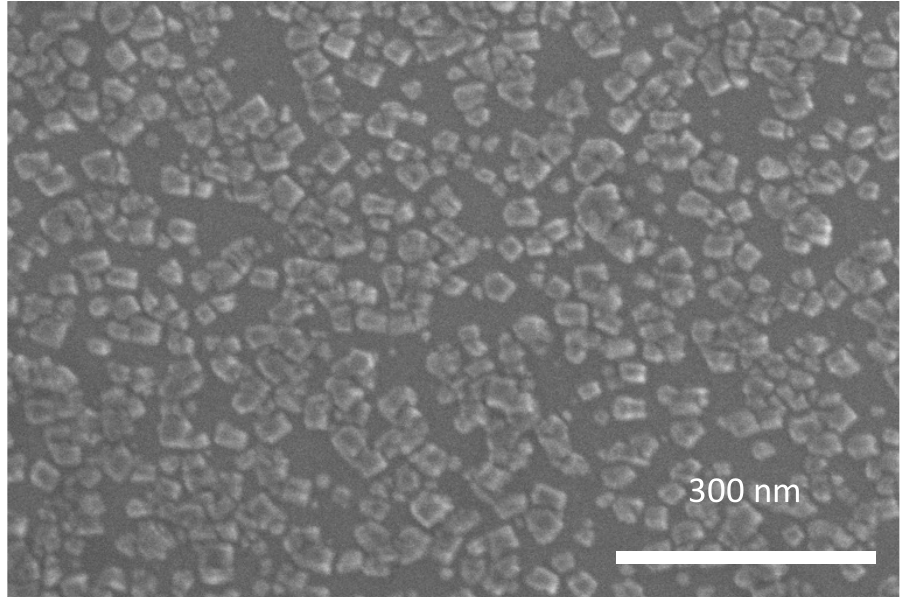
Figure 4. SEM image of Cu NP co-deposited with Mg in O atmosphere. The nominal thickness for Cu NP and MgO are t Cu = 0.4 nm, t MgO = 1 nm.